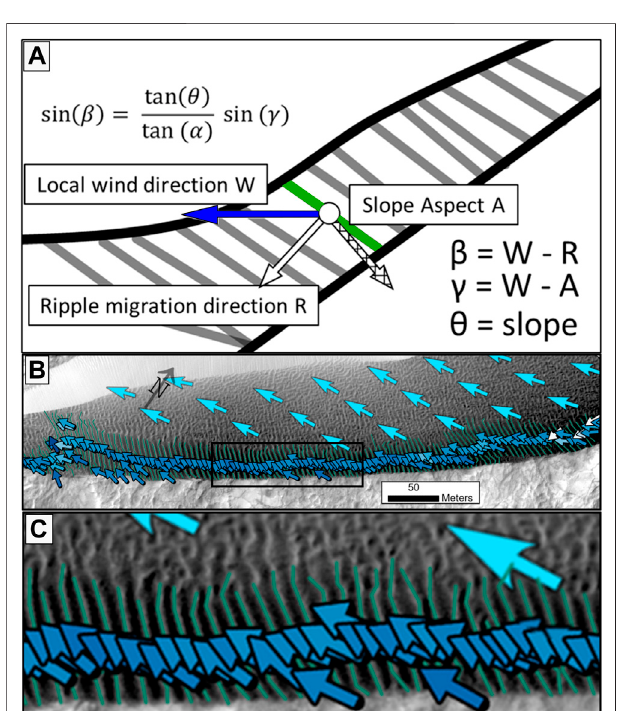
FIGURE 3 | (A) A visual expression of the Howard Equation ( Eq. 1 ), (B) study site D with COSI-Corr derived ripple motion on the dune top (light blue arrows) and ripple traces (green) with interpreted wind direction (blue arrows), (C) detail of panel B.